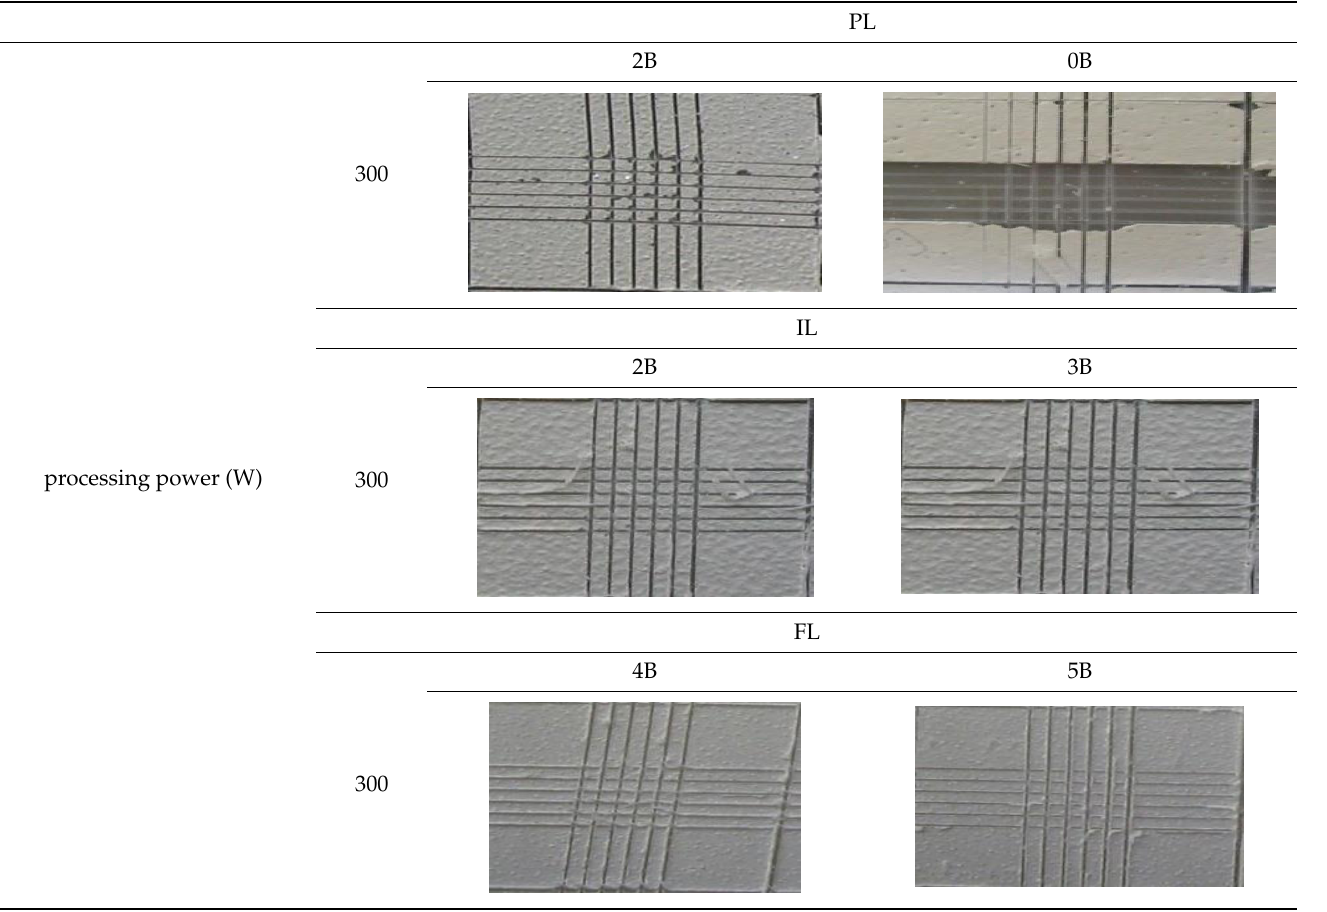
Table 2. Adhesion result for the steel coating under the treatment conditions of 2 min at 300 W.